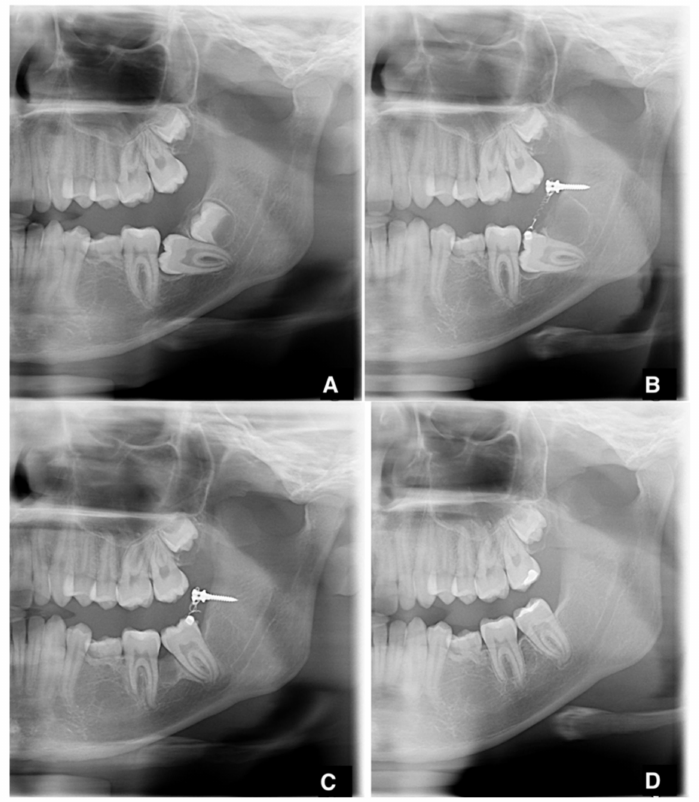
Figure 1. ( A – D ) The whole radiographic sequence of intervention (case